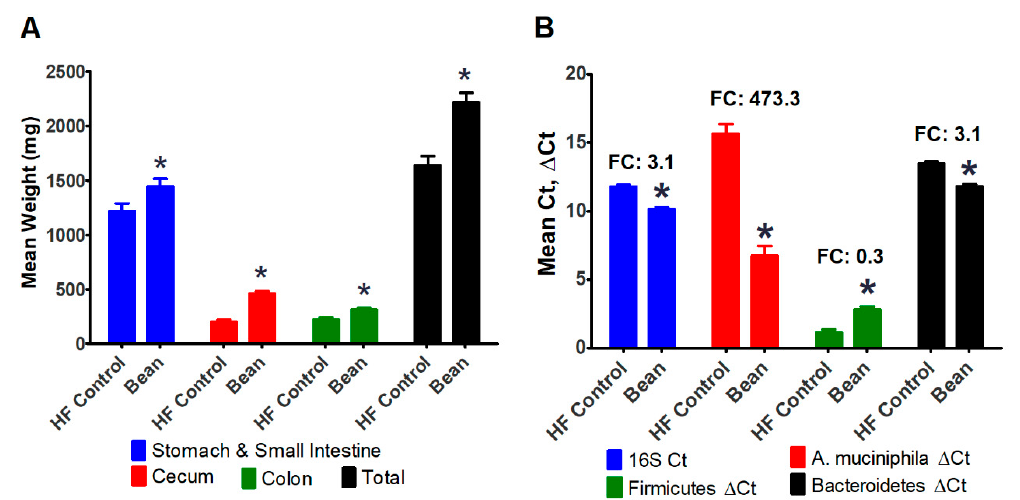
Figure 4. Effects of paired-feeding of white kidney bean on intestinal mass and cecal bacterial populations (Experiment 2). ( A ) Intestinal weights; ( B ) Cecal bacteria populations; ANOVA: Stomach Small Intestine p = 0.0343, Cecum p < 0.0001, Colon p = 0.0027, Total p = 0.0003; 16S Ct p = 0.0001, A. muciniphila ∆ Ct p < 0.0001, Firmicutes ∆ Ct p = 0.0004, Bacteroidetes ∆ Ct p = 0.0001; * different relative to HF control diet ( p ≤ 0.05); Control n = 8, Bean n = 8; FC: fold change; HF: high fat.